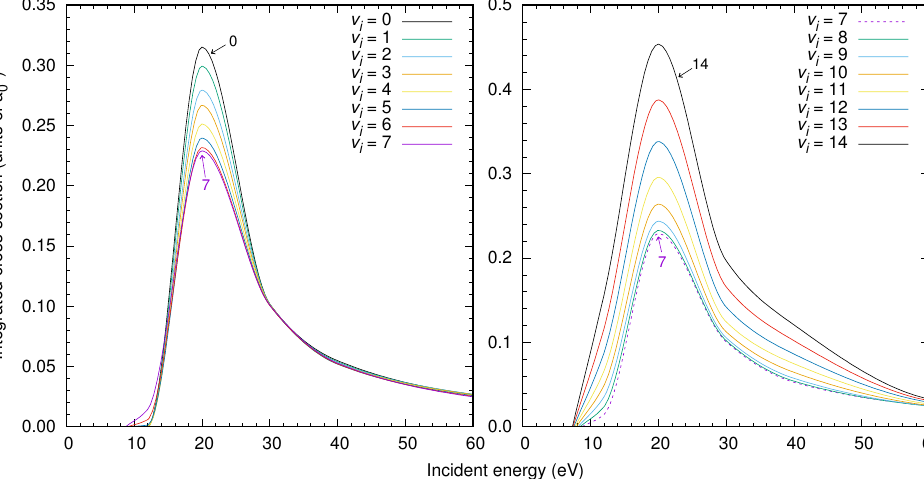
Figure 2. Electron-impact cross sections for excitation from the v i = 0–14 vibrational levels of the X 1 Σ + g state to the bound electronic triplet spectrum of H 2 (minus the b 3 Σ + u state). The cross sections decrease with increasing v i up to v i = 7 ( left ), and rise with increasing v i for v i > 7 ( right